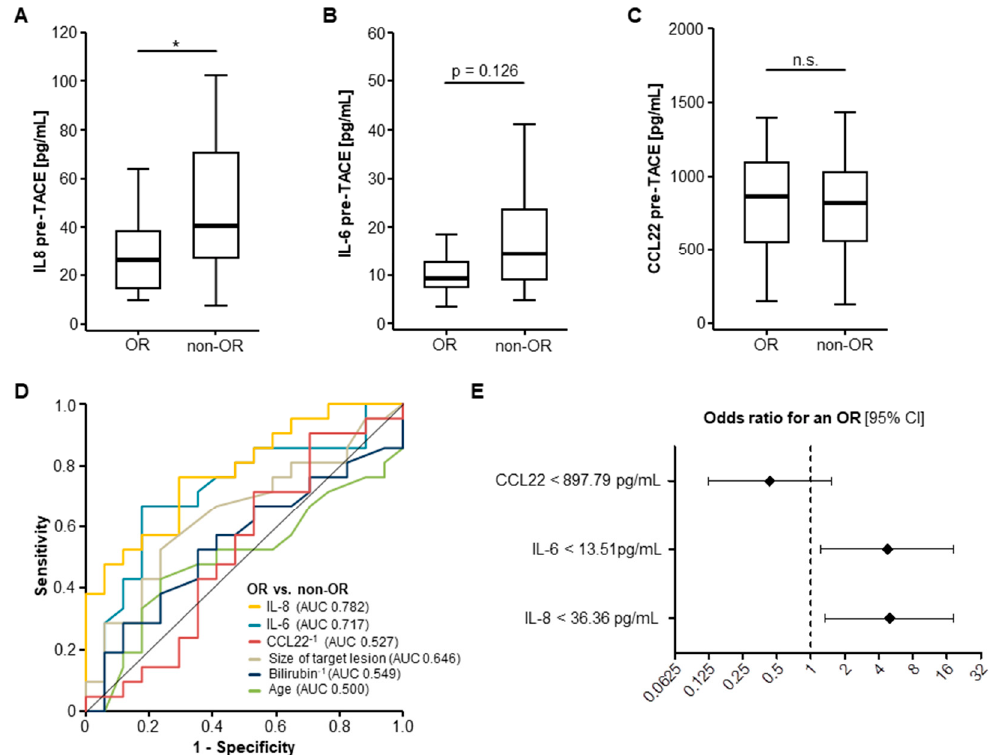
Figure 2. Pre-interventional serum levels of IL-8 and IL-6 predict an objective response after TACE. ( A ) Pre-treatment serum levels of IL-8 are significantly lower in patients who showed an objective response (OR) to TACE compared to non-responding (non-OR) patients; ( B ) Initial serum IL-6 levels similarly show a strong trend towards lower serum concentrations in OR patients; ( C ) Circulating levels of CCL22 are unaltered between OR and non-OR patients; ( D ) ROC curve analysis for the discrimination between OR and non-OR patients; ( E ) Univariate binary logistic regression analysis reveals circulating IL-6 and IL-8 but not CCL22 levels as predictors of an objective response to TACE (black diamond: odds ratio, error bars: 95% confidence interval (CI). (* p < 0.05; ** p < 0.01; *** p < 0.001; n.s.: p > 0.05).